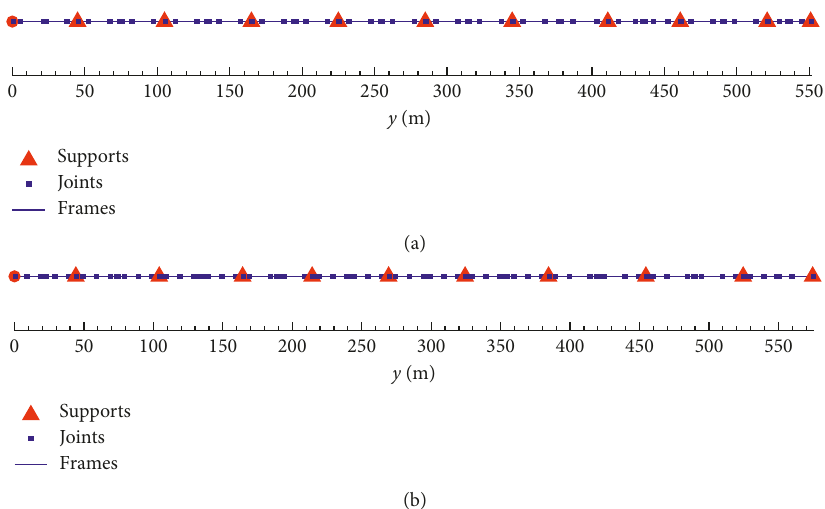
Figure 5: Schematic representation of the girder FE models in the two design alternatives. (a) Alternative 1: G1. (b) Alternative 2: G2.